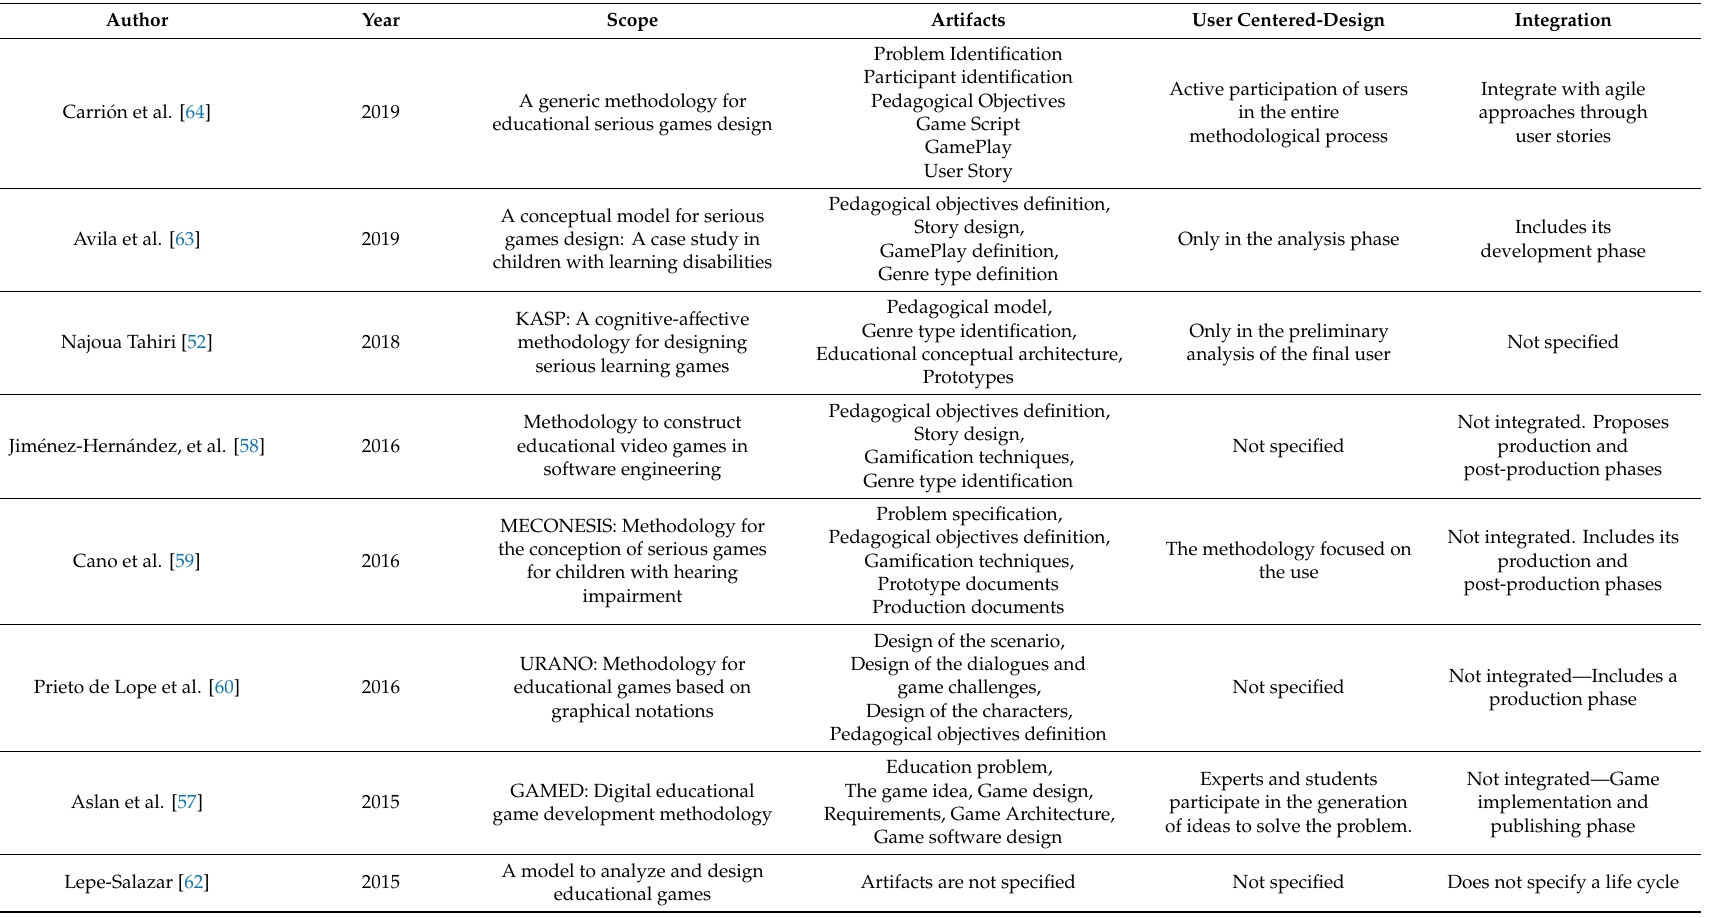
Table 1. Comparison of